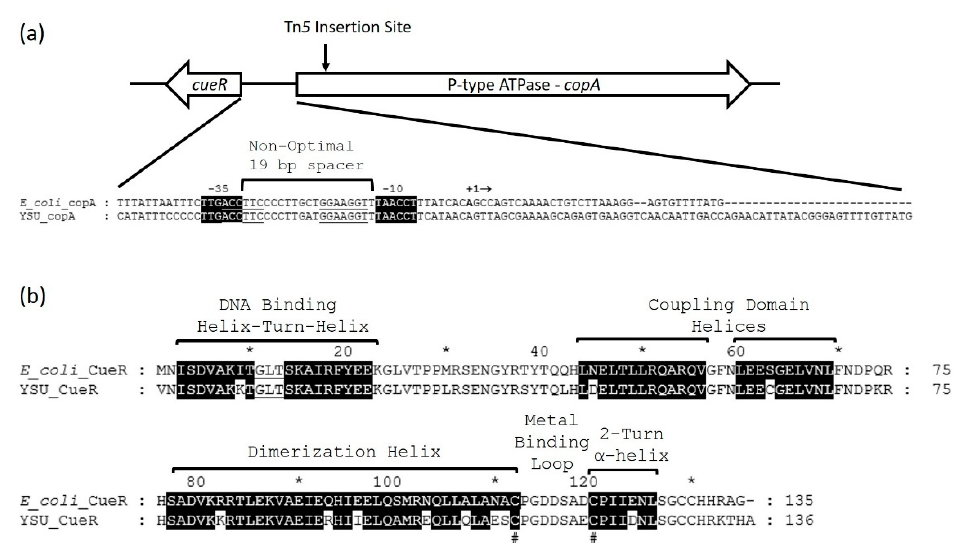
Figure 4. The Enterobacter sp. YSU copper resistance operon and the CueR activator/repressor switch. ( a ) The Enterobacter sp. YSU copA gene and its predicted promoter region using the E. coli copA promoter region. The gene for cueR is adjacent to copA in Enterobacter sp. YSU but not in E. coli . An arrow indicates the Tn 5 transposon insertion site in copA . The promoter region contains a non-optimal 19 bp spacer region and a CueR binding site (underlined) between the predicted -10 and -35 regions. Identical nucleotides in the -10 and -35 regions are highlighted in black. The first three base pairs, CAT, on the far left of the YSU_copA sequence marks the beginning of CueR translation in Enterobacter sp. YSU. The last three base pairs, ATG, on the far right marks the beginning of CopA translation in both strains. ( b ) Prediction of the Enterobacter sp. YSU CueR secondary structure using the E. coli CueR amino acid residue primary sequence. Like MerR, the CueR helix-turn-helix domain binds to the operator region of the promoter in the DNA. The coupling domain links the DNA binding domain to the metal binding domain. The metal binding domain consists of a dimerization helix, metal binding loop and 2-turn α -helix. The amino acids residues that are highlighted in black are identical to amino acid residues in the helices of E. coli CueR. The # below the sequences designates cysteine amino acid residues which bind to Cu(I). The * and numbers above the CueR primary sequences denote the position of every 10 amino acid residues.